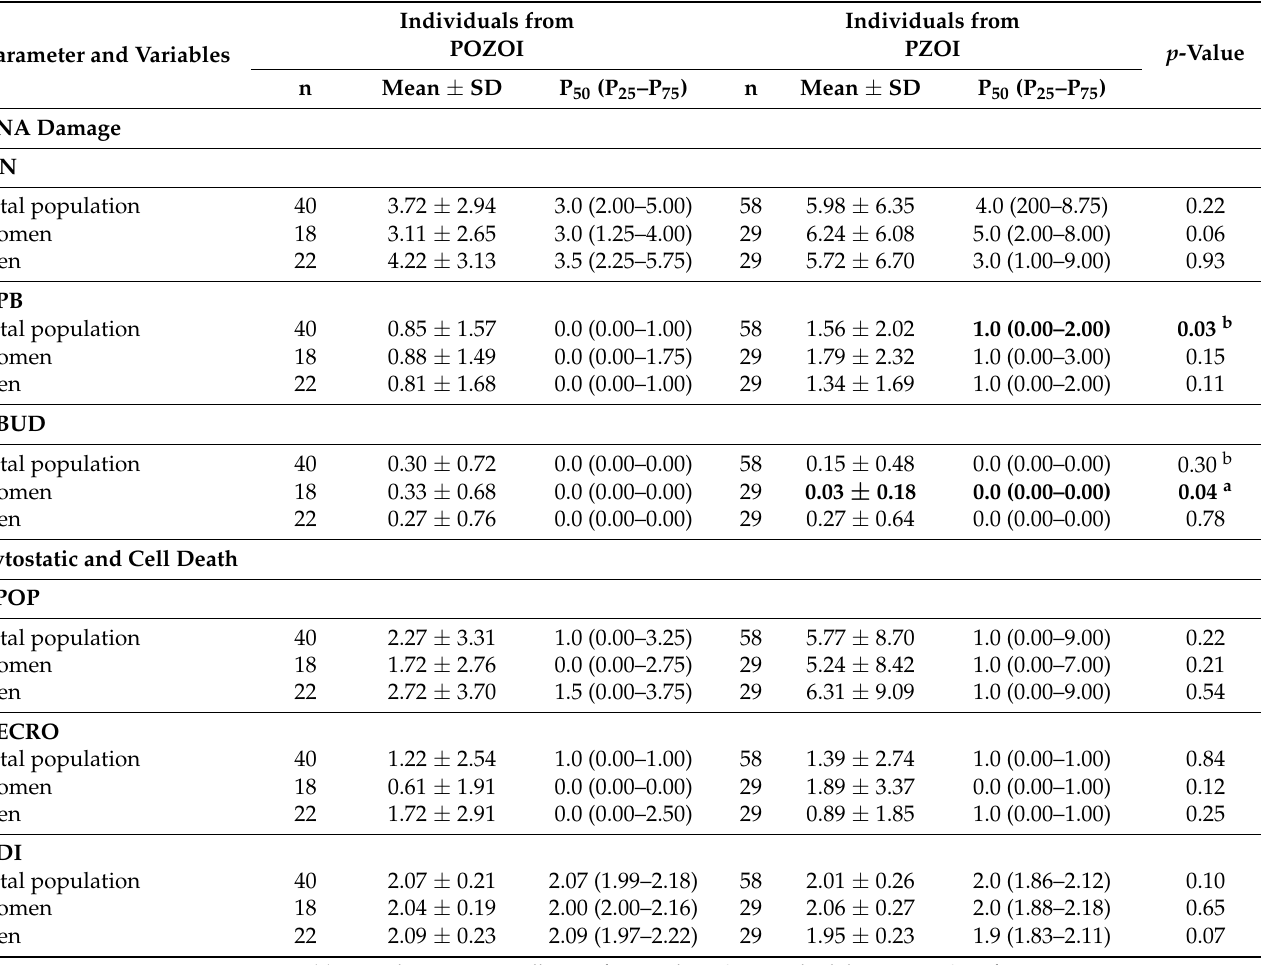
Individuals from PZOI